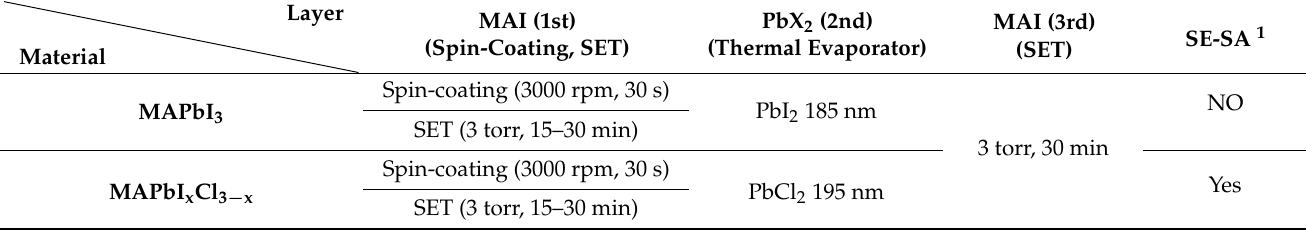
Figure 1. Different fabrication route for perovskite sandwich structure. Table 1. Different stage fabrication parameters of perovskite sandwich structure.